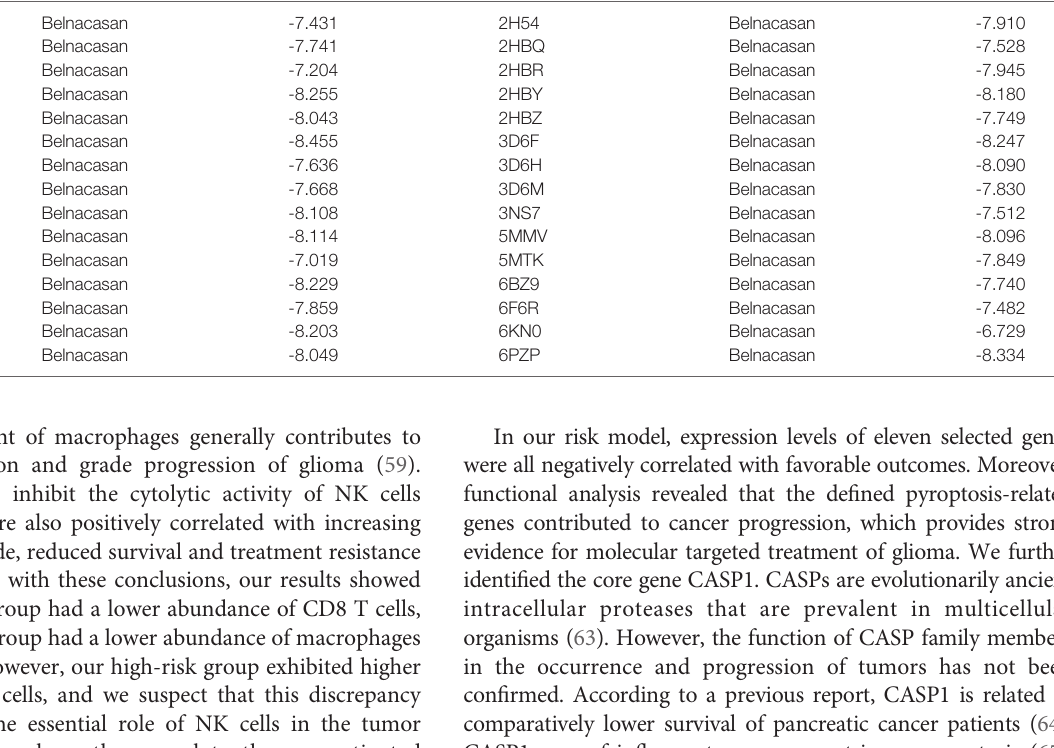
TABLE 3 | Interaction force of belnacasan with all PDB structures of the CASP1 gene. PDB